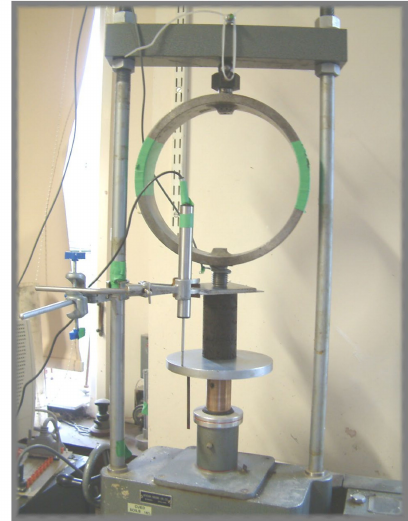
Figure 4. Unconfined compression